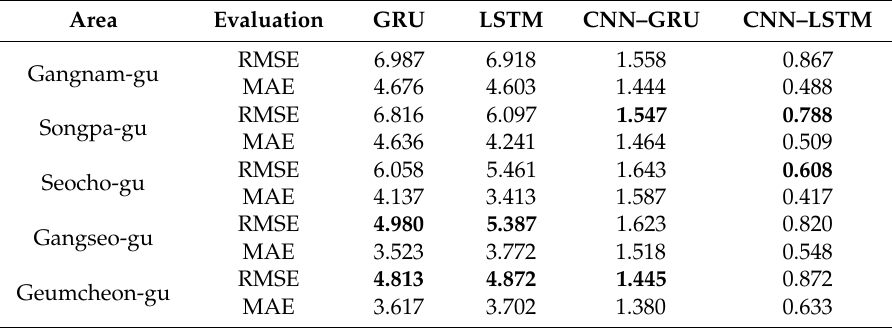
Table 9. Seven-day predictions of PM 2.5 levels in five